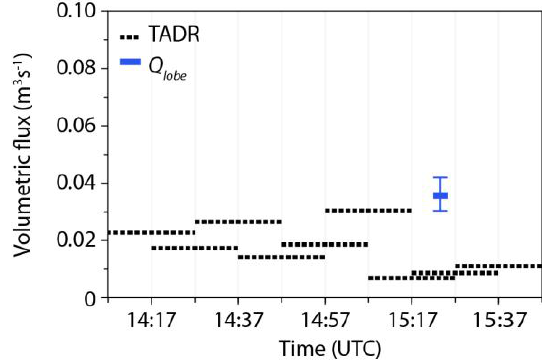
Figure 4. Volumetric flux estimates for the breakout lobe. Time-averaged discharge rate (TADR) values are calculated from the elevation difference maps, with each line bracketing the entire start-to-end duration of the each scan pair used in the calculation. The estimated error in TADR is approximately the line thickness. The local effusion rate for the breakout flow lobe, Q lob e (Section 4.3), is shown with the error bars illustrating the estimated minima and maxima